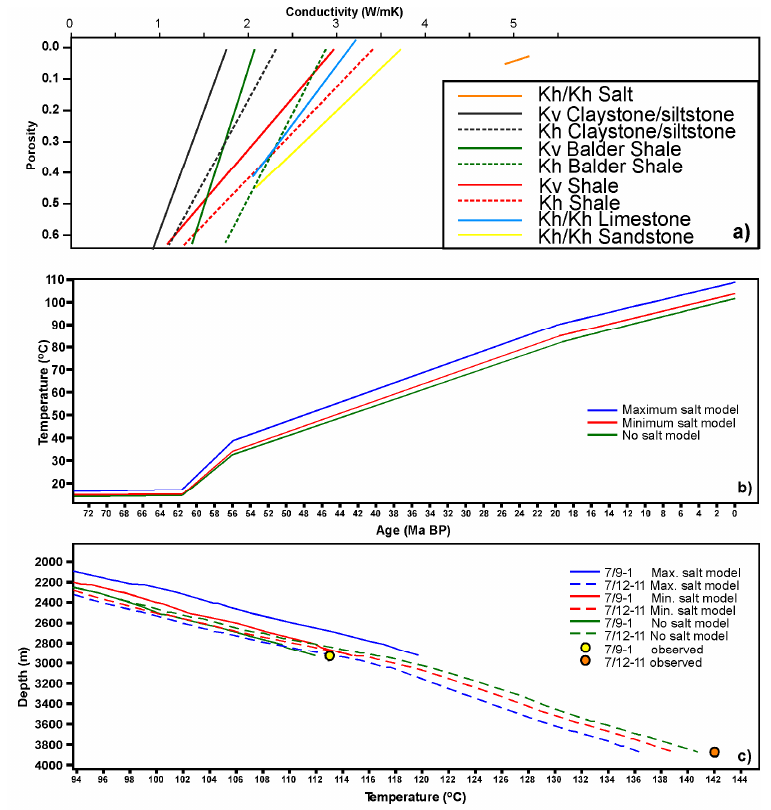
Figure 18. Thermal conductivity and temperature history for the three salt models shown in Figure 13. a ) Thermal conductivities used in the modeling. Kv = vertical conductivity, Kh = horizontal conductivity. Note that shale and claystones have different Kv and Kh. Other lithologies have uniform conductivities in both directions. b ) Calculated temperature history for the point above the salt close to base of well 7/9-1 (position shown in Figure 13). c ) Present day calculated and observed temperature in wells 7/9-1 and 7/12-11.